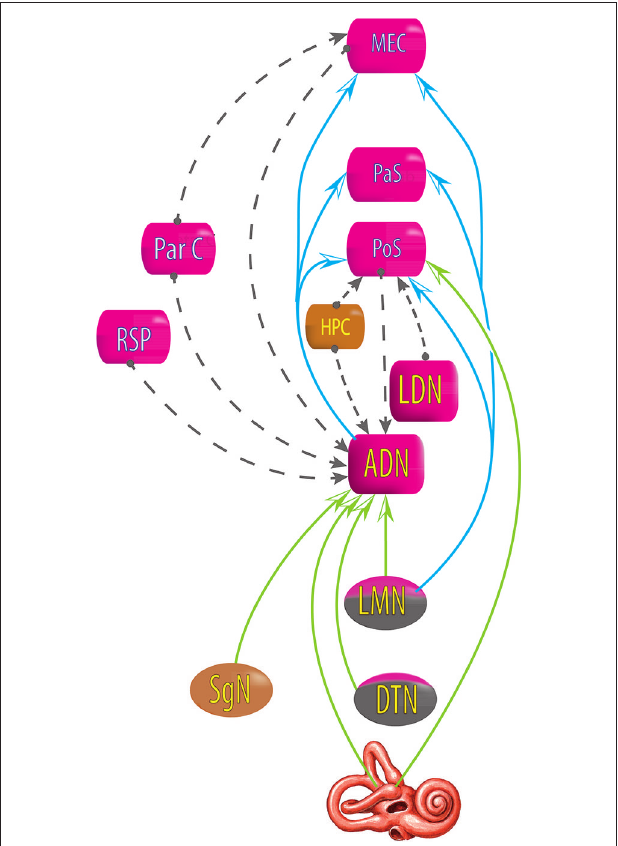
FIGURE 5 | Relationship between areas exhibiting head direction signals, deduced from lesion studies . Blue and green arrows: lesions at the starting area disrupt the head direction signal in the end area. Gray dashed line arrows: lesions at the starting area do not disrupt head direction signal in the end area. DTN, dorsal tegmental nucleus; LMN, lateral mammillary nucleus; AND, antero dorsal nucleus of the thalamus; LDN, latero dorsal thalamus; HPC, hippocampus; PoS, posterior subiculum; RSP, retrosplenial cortex; ParC, partietal cortex; PaS, parasubiculum; MEC, medial entorhinal cortex (see review in Clark and Taube, 2012).